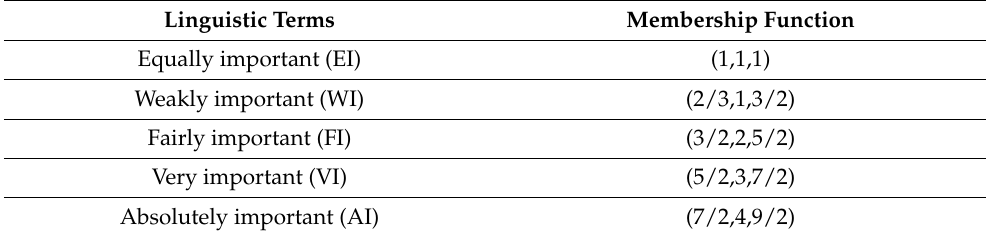
Table 6. Fuzzy linguistic scale [67].